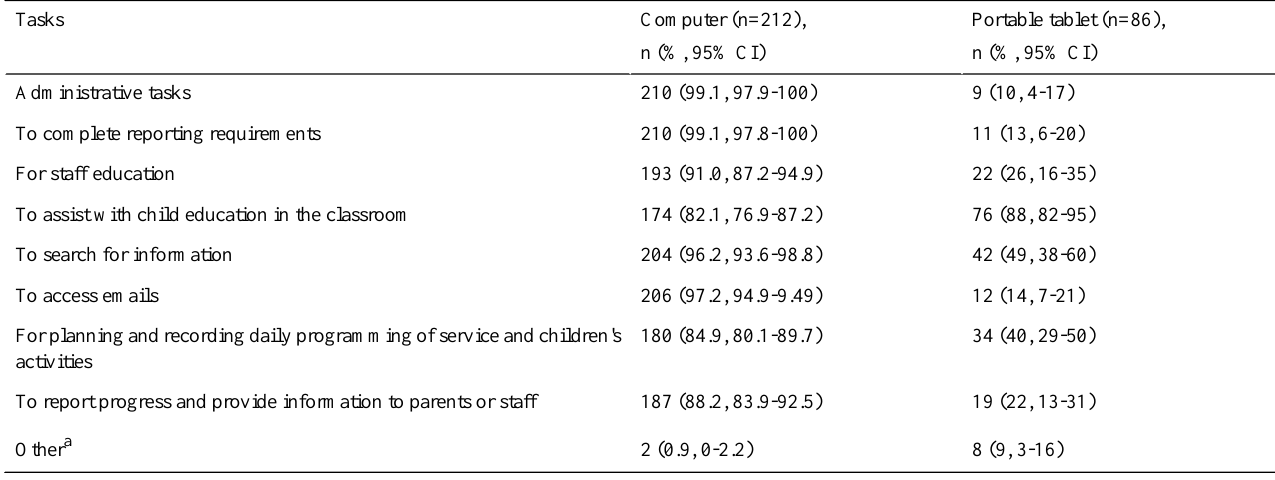
Table 2. Use of computers and portable tablets by childcare center